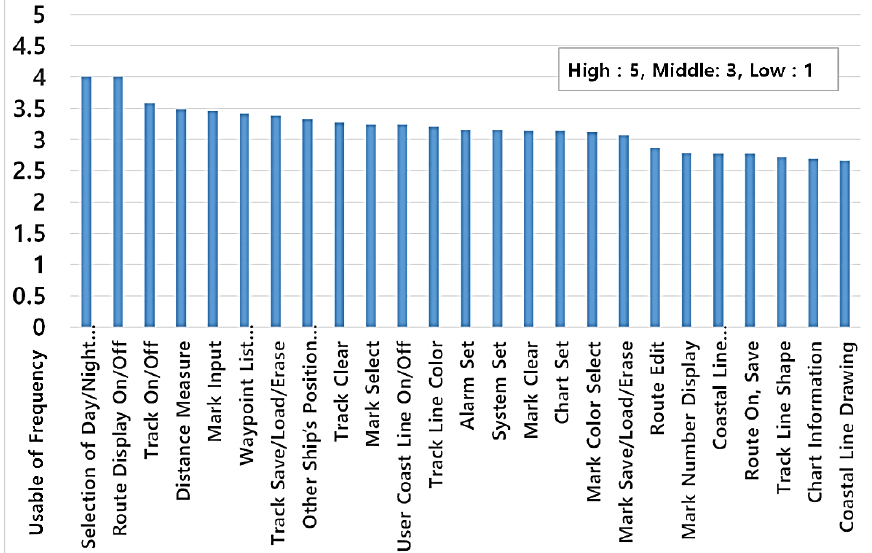
Figure A10. Frequency of use of GPS plotters functions. Average (1: Worst to 5: